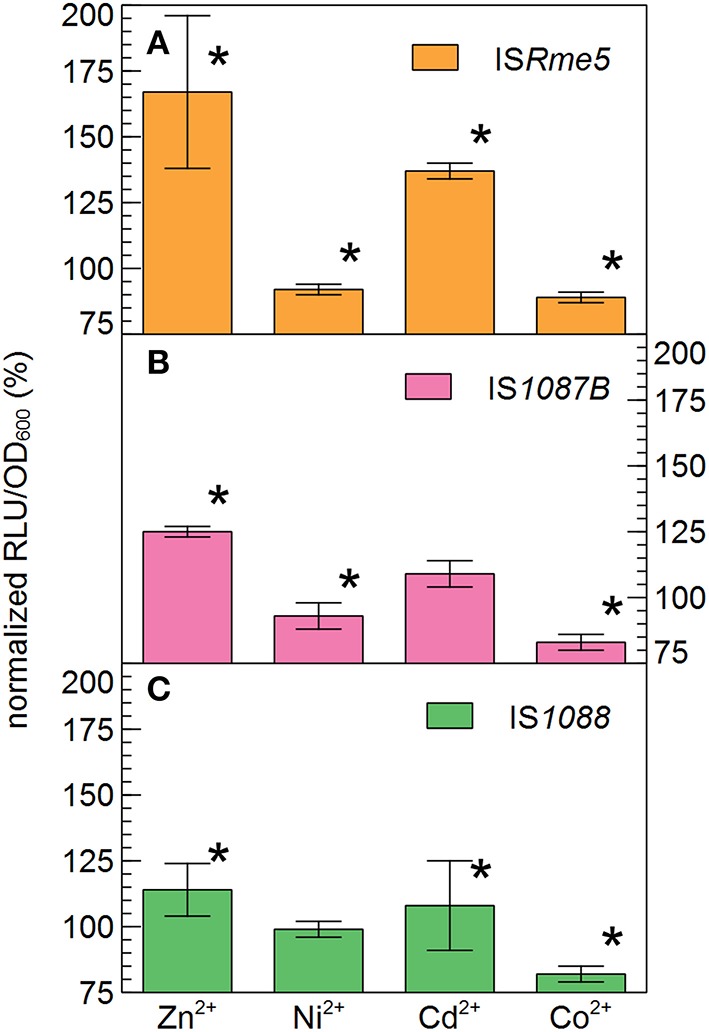
Endogenous promoter activity of the ISRme5 (A), IS1088 (C), and IS1087B (B) transposase in response to Zn2+ (100 μM), Ni2+ (100 μM), Cd2+ (10 μM) and Co2+ (50 μM) after 4 h of incubation, calculated by normalizing the reporter signal RLU to cell density ratio (RLU/OD600) to that of the control without added metals. *indicates a significant difference between the tested metal ion and the control, determined by a t-test with a p < 0.05. The average values of three independent experiments with standard deviations are shown.